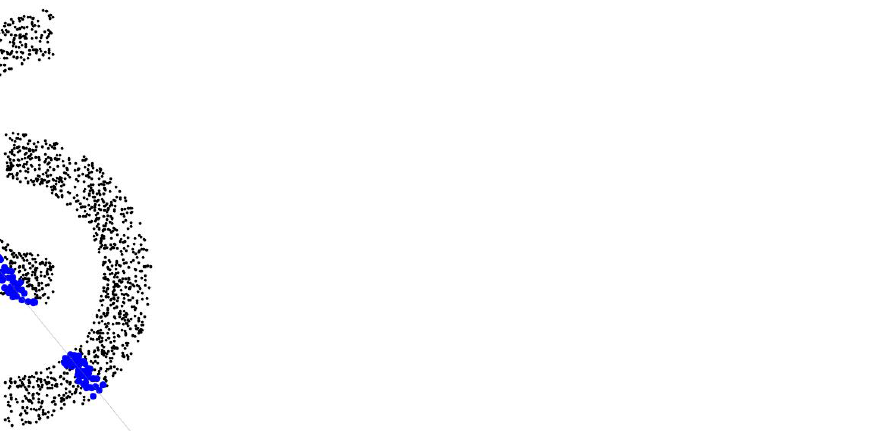
Figure 6. SVM with linear kernel behaves similarly to the Helstrom method in the smallest space.